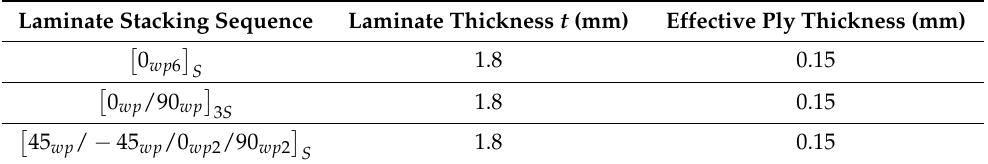
Table 2. Details of laminates’ stacking sequences with uniform wrinkles. Laminate Stacking Sequence